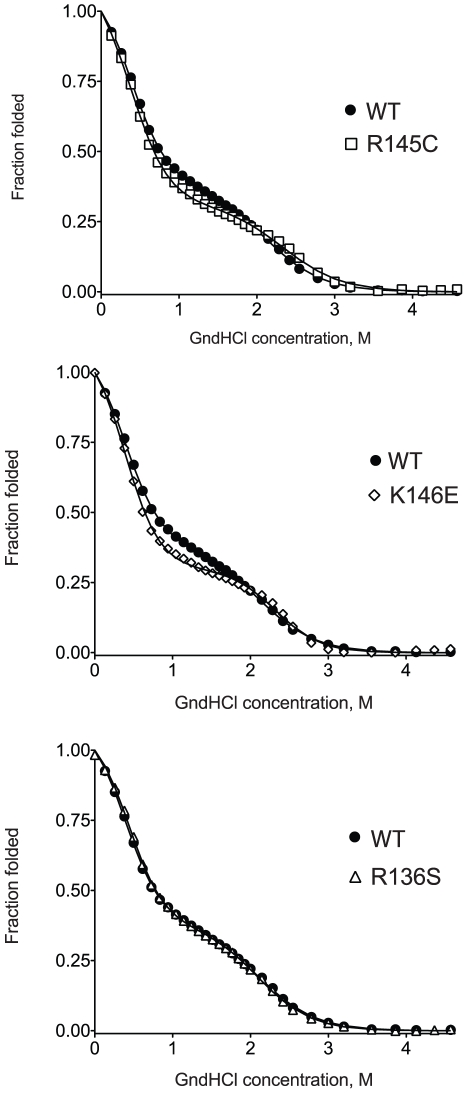
Chemical denaturation profiles of wild-type apoE3 and apoE3 variants.Each variant is presented in comparison with the wild-type protein (black circles). Solid lines represent non-linear regression fits to a three-state unfolding model as described in the materials and methods section.